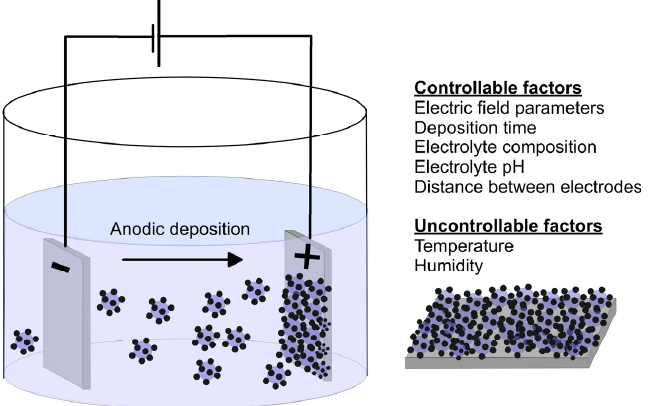
Figure 6. Schematic representation of the EPD process for the production of composite coatings on a metallic substrate.